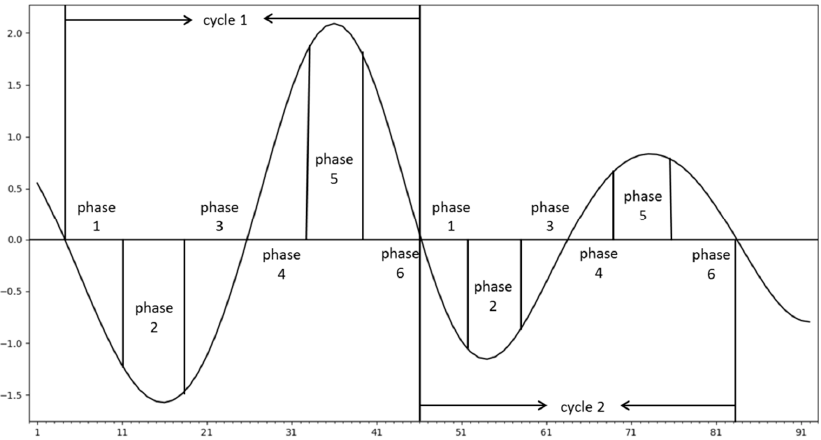
Figure 12. The 30–60 days ISO of the EASM cycles and phases in 1998. (Abscissa represents June August, ordinate represents the ISO oscillation intensity of 30–60